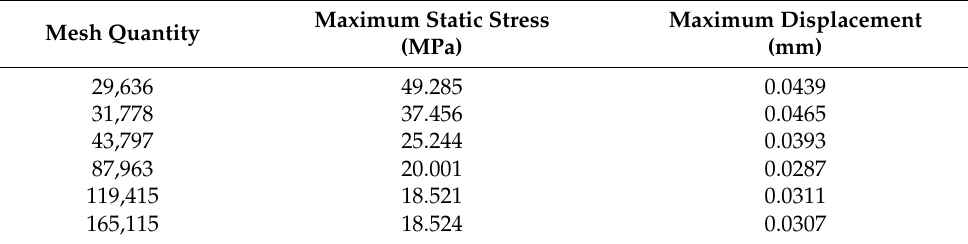
Table 2. Calculated values of the objects under the condition of different mesh quantities.